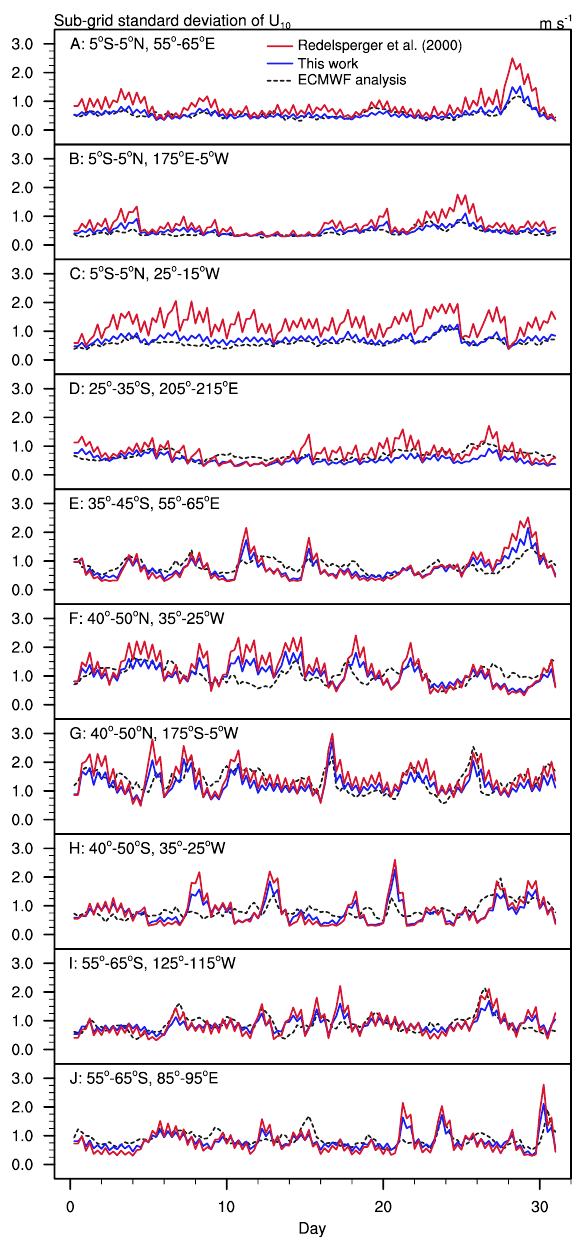
Figure 8. Time series of the sub-grid standard deviation of U 10 (ms − 1 ) in January 2012 averaged over the 10 ◦ × 10 ◦ hatched boxes in Fig. 1. Dashed black curves are directly diagnosed from the ECMWF surface wind data. Solid blue and red curves are the σ U, m calculated using the ECMWF precipitation rates and the em- pirical formulas of this study (Eq. 23) and Redelsperger et al. (2000) (Eq. 22), respectively.